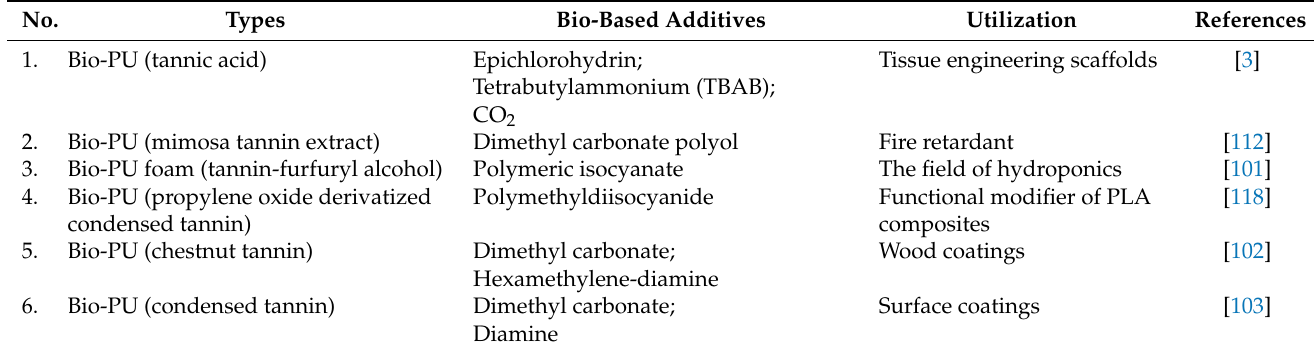
Table 6. Utilization of tannin-based bio-PU